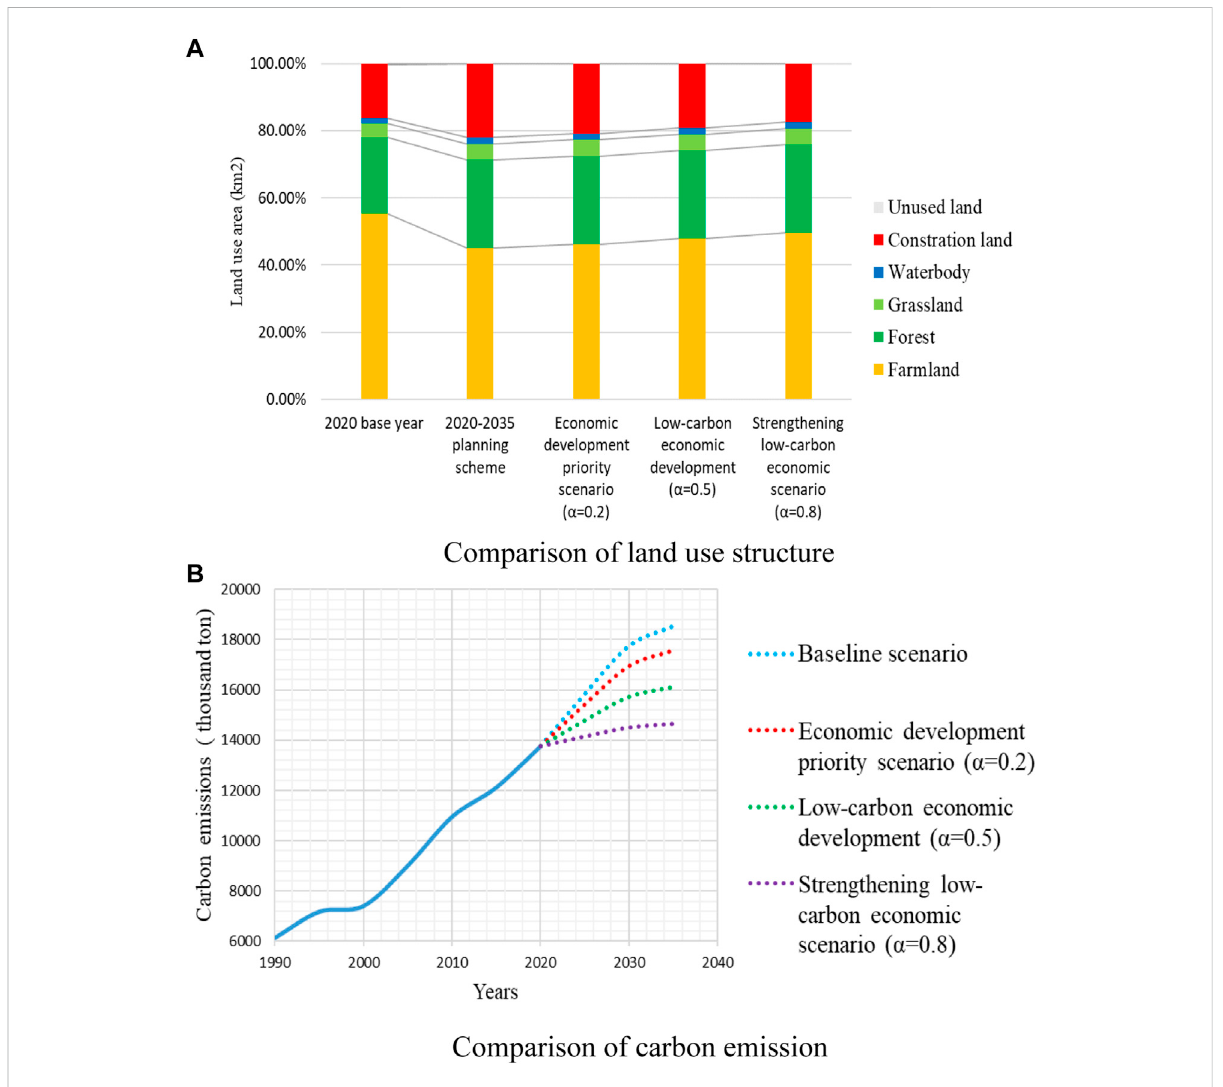
FIGURE 4 Optimize the land use structure and carbon emission reduction potential of the